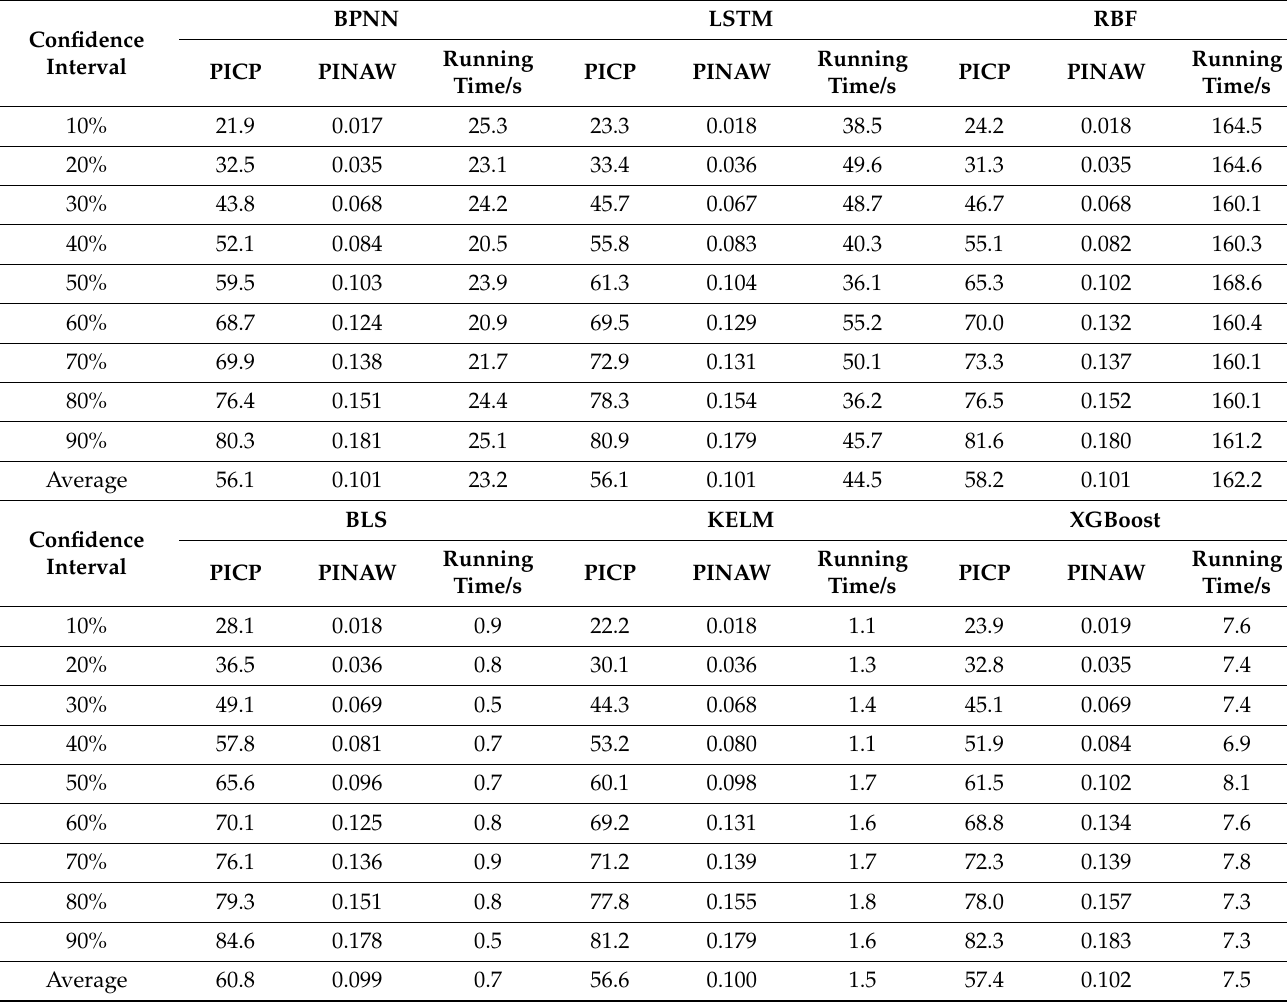
Table 3. Accuracy comparison between different models in Set